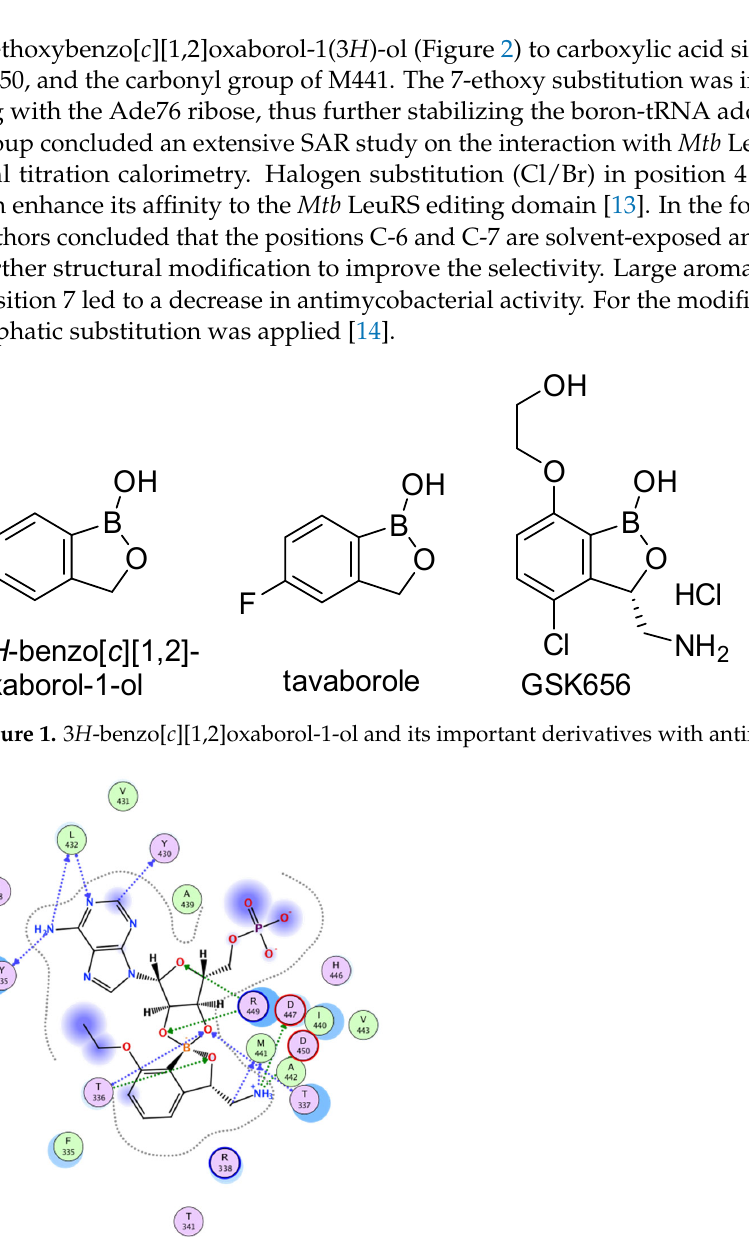
Figure 1. 3 H ‐ benzo[ c ][1,2]oxaborol ‐ 1 ‐ ol and its important derivatives with antimicrobial activity.